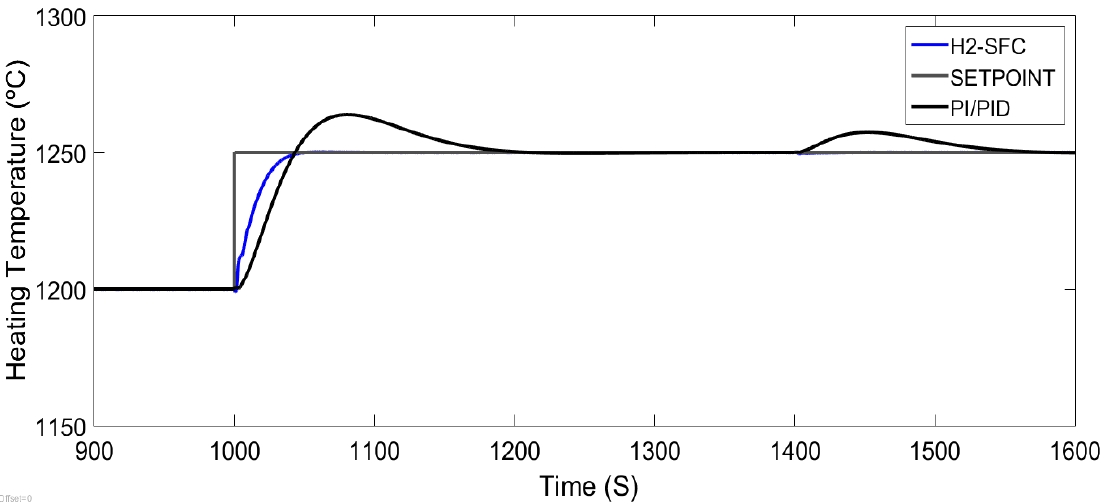
Figure 8. Time responses with H 2 -SFC and PID controllers in the presence of an external step disturbance.